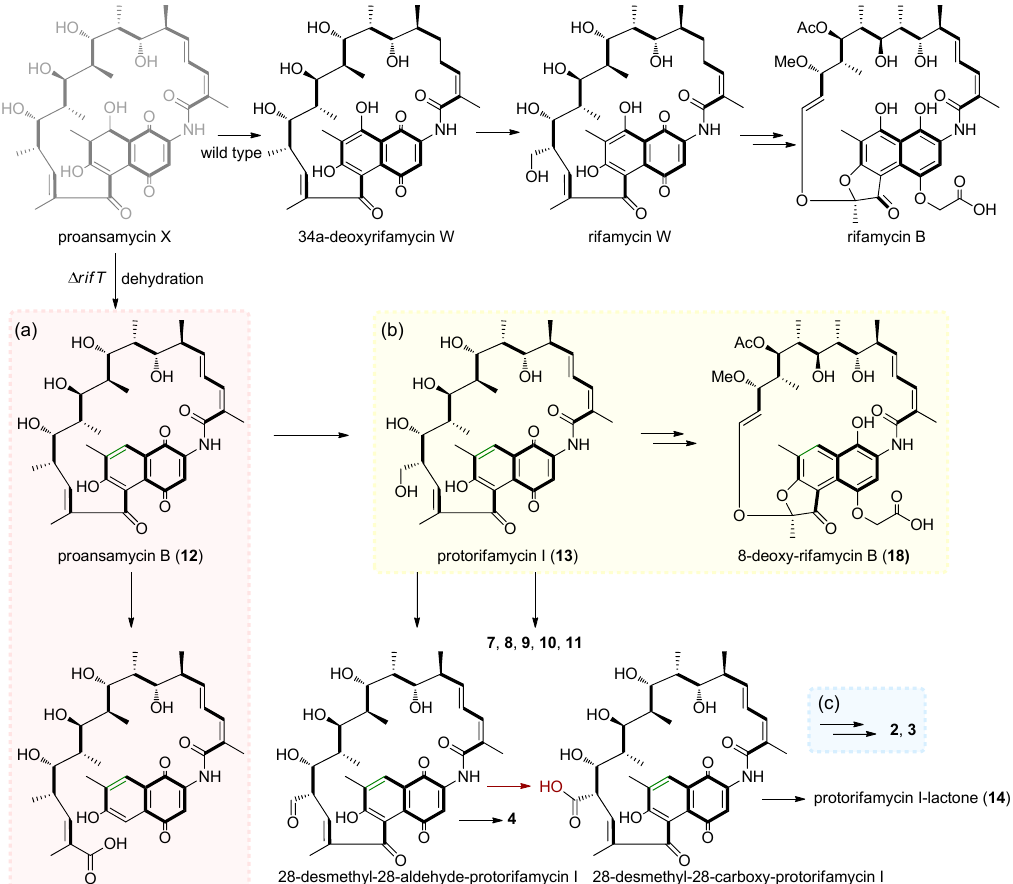
Figure 4. Three cleavage patterns of the ansa chain in the biosynthesis of 8-deoxy-rifamycins. ( a ) 5,11 retro-Claisen cleavage lead to proansamycin B-M1 ( 15 ). ( b ) 12,19 double bond cleavage lead to 8-deoxy-rifamycin B ( 18 ). ( c ) 11,12 Baeyer-Villiger oxidation cleavage to 2 and 3 .